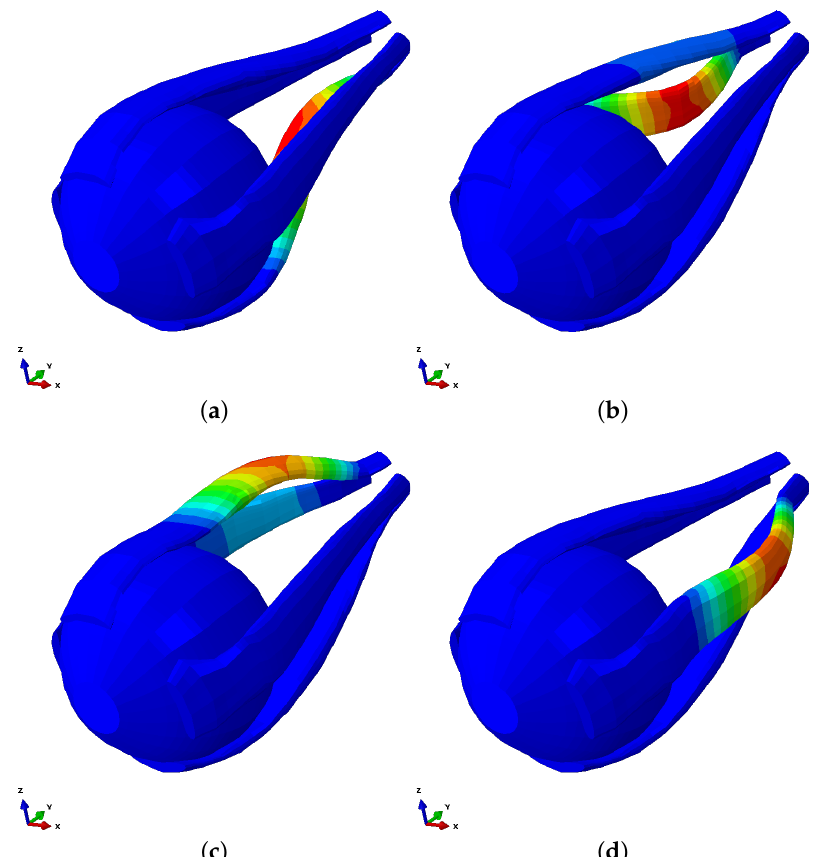
Figure 4. Initial four mode shapes obtained for the right eyeball and EOMs system. These modes correspond with bending of the EOMs at natural frequencies of: ( a ) 55.33 Hz for the inferior EOM; ( b ) 72.57 Hz for the lateral EOM; ( c ) 72.84 Hz flexion mode for the superior EOM; and ( d ) 84.16 Hz for the medial EOM.